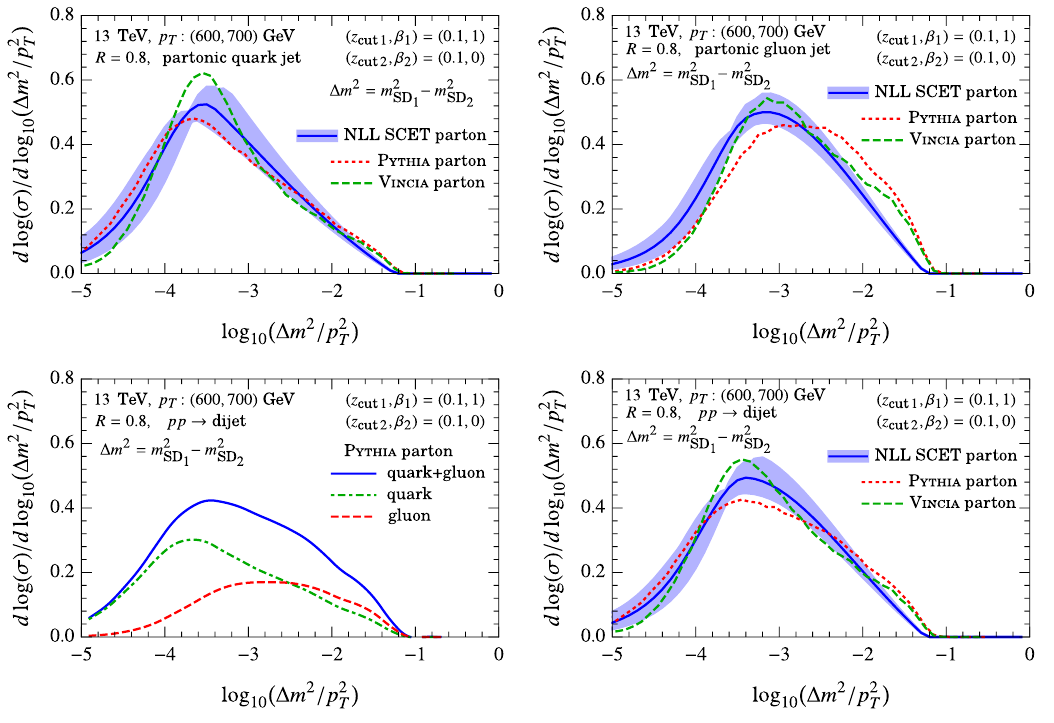
Figure 14 . Collinear Drop distributions with ( z cut1 ; (cid:12) 1 ) = (0 : 1 ; 1) and ( z cut2 ; (cid:12) 2 ) = (0 : 1 ; 0) from Pythia and Vincia simulations as well as SCET calculations with theoretical uncertainty estima- tion (blue bands). The top two panels show the distributions for quark-initiated jets (left panel) and gluon-initiated jets (right panel), and the bottom right panel gives the dijet distributions. The bottom left panel gives a decomposition of the Collinear Drop distribution from Pythia simulations into quark and gluon